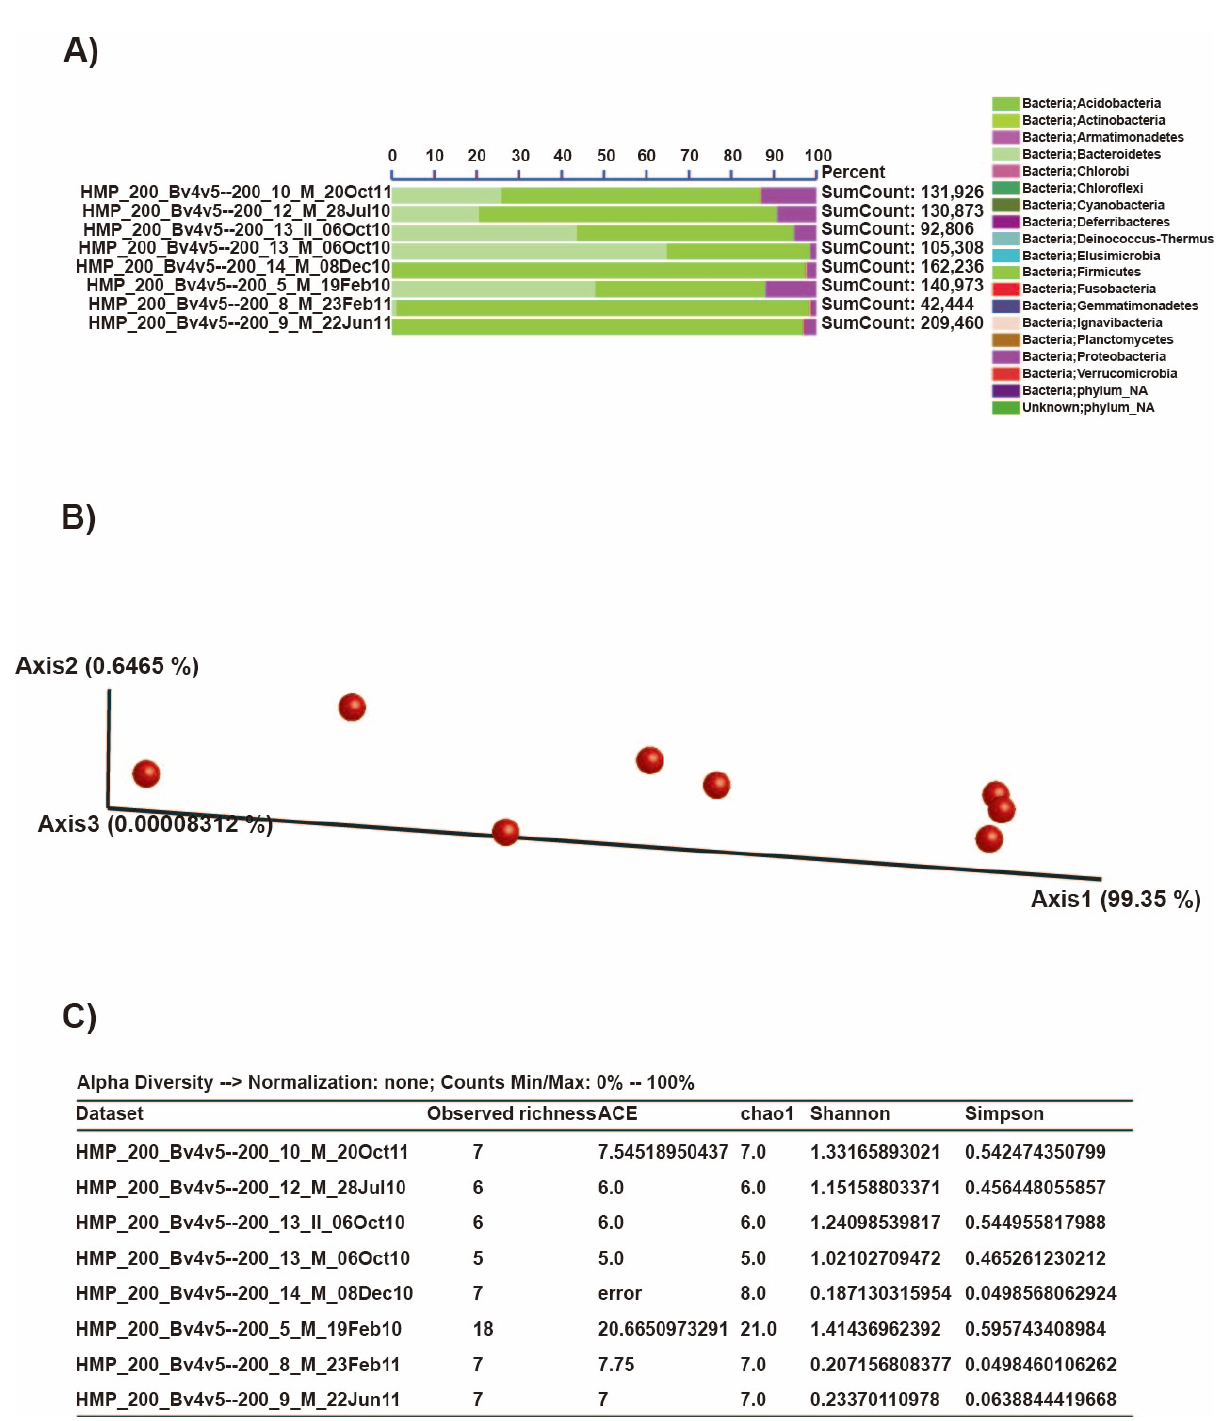
Figure 4. Output figures for ( A ) taxonomic data (phyla), ( B ) beta diversity (Bray–Curtis dissimilarity), and ( C ) alpha diversity (Observed richness, Ace, Chao1, Shannon, and Simpson indices) using the HMP_200 dataset that is readily available in VAMPS.